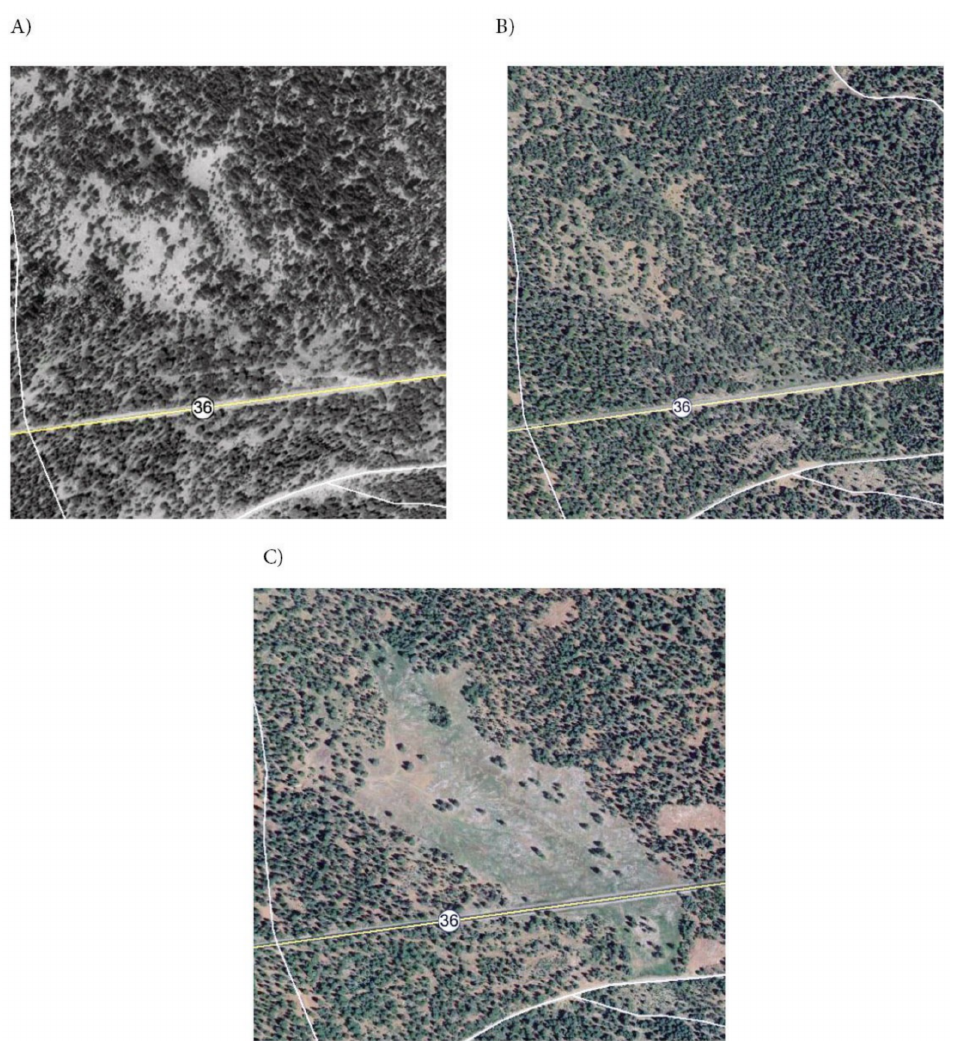
Figure 2. Marian Meadow with increasing lodgepole pine encroachment prior to restoration and following restoration from removal of encroached lodgepole pine (Imagery from Google